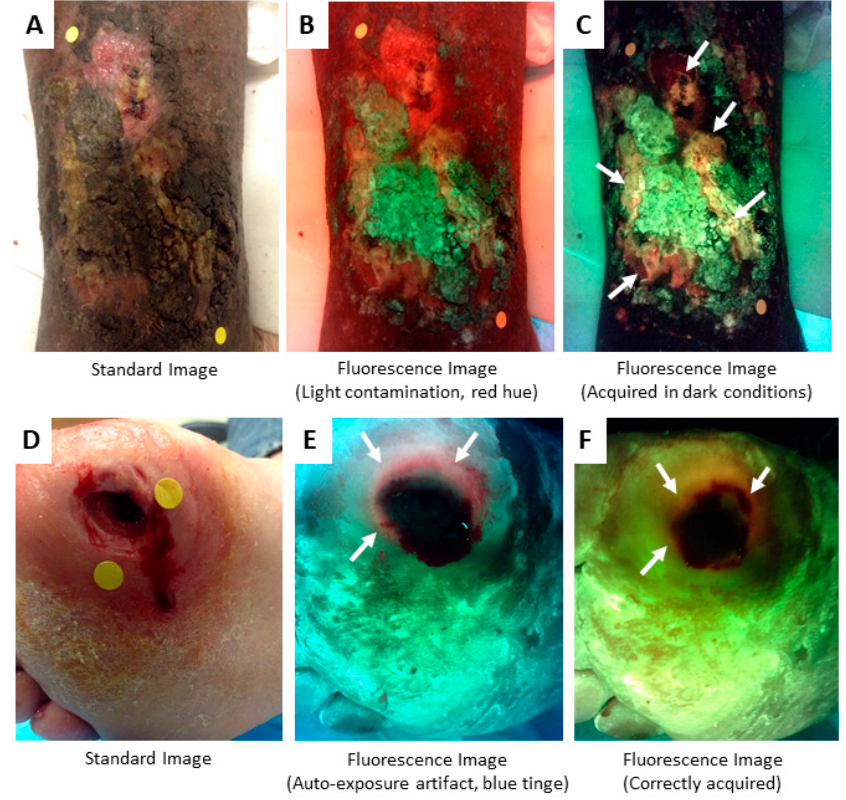
Figure 7. Imaging artifacts to be avoided. ( A – C ) Light contamination gives the fluorescence image in panel B a reddish tinge. This obscures detection of bacterial fluorescence, which was clearly present (arrows) when wound was imaged under dark conditions ( C ). ( D – F ) The violet illumination light should only be turned on after darkness has been obtained to avoid a bluish artifact from auto-exposure as seen in ( E ). When correctly acquired, as in ( F ), the skin will have a greenish hue. White arrows denote regions of red fluorescence.